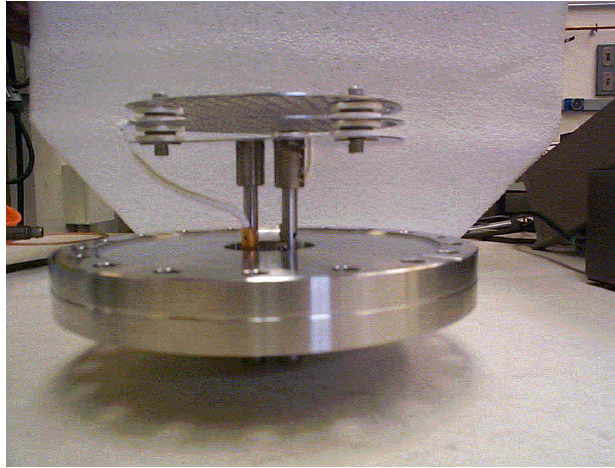
FIG. 7. (Color) Multigrid electron detector in RHIC. The grids have a diameter of 12 cm [43].